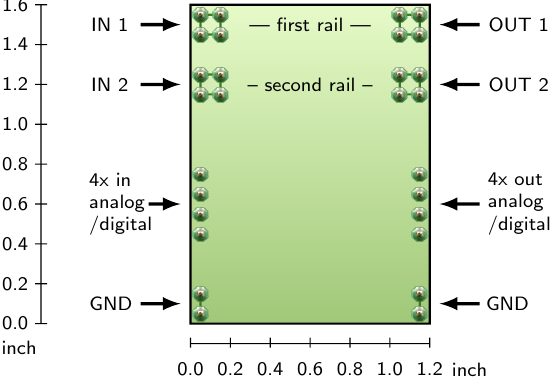
Figure 4. Standard module layout to hold one power management function, measuring 1.2 (cid:48)(cid:48)